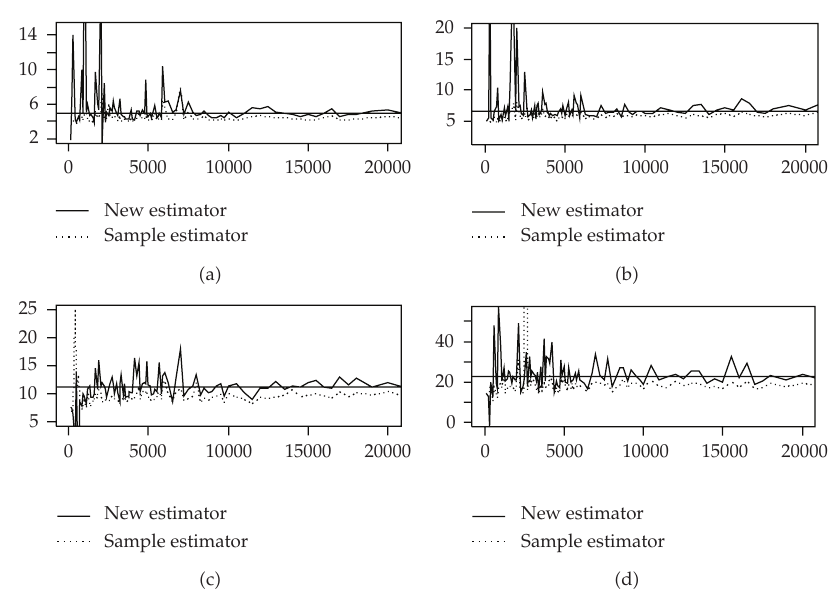
(cid:8) Figure 2: Values of the CTE estimator CTE n (cid:2) t (cid:3) (cid:2) vertical axis (cid:3) versus sample sizes n (cid:2) horizontal axis (cid:3) evaluated at the levels t (cid:7) 0 . 25, t (cid:7) 0 . 50, t (cid:7) 0 . 75, and t (cid:7) 0 . 90 (cid:2) panels (cid:2) a (cid:3) – (cid:2) d (cid:3) , resp. (cid:3) in the Pareto case with the tail index γ (cid:7) 3 /